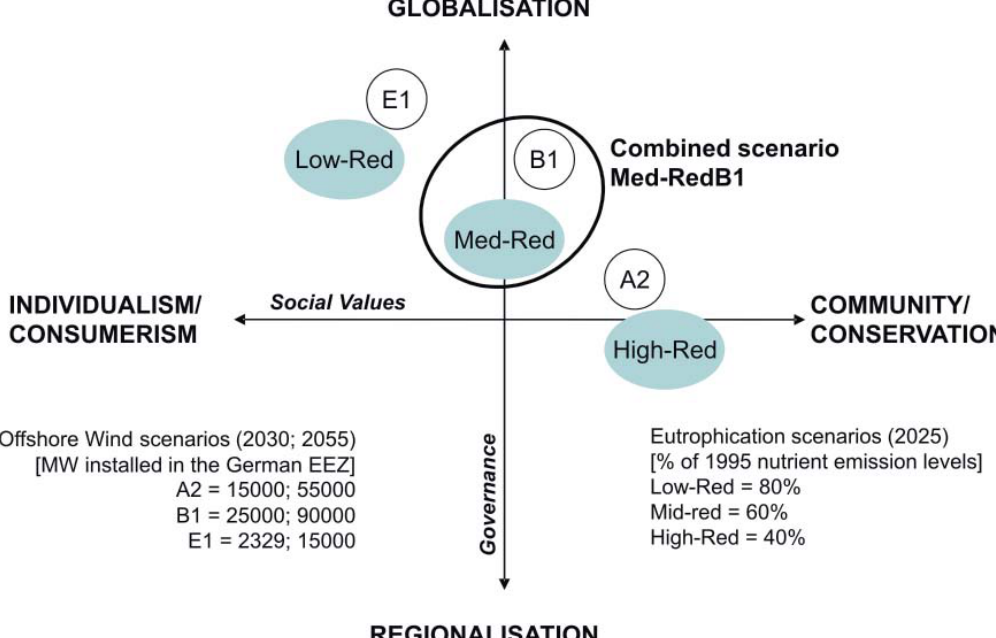
Figure 2. Scenario position with respect to governance and social values in them represented. Based on these aspects, scena- rios dealing with different issues can be combined based on the assumptions underlying more general aspects regarding world visions, perceptions and